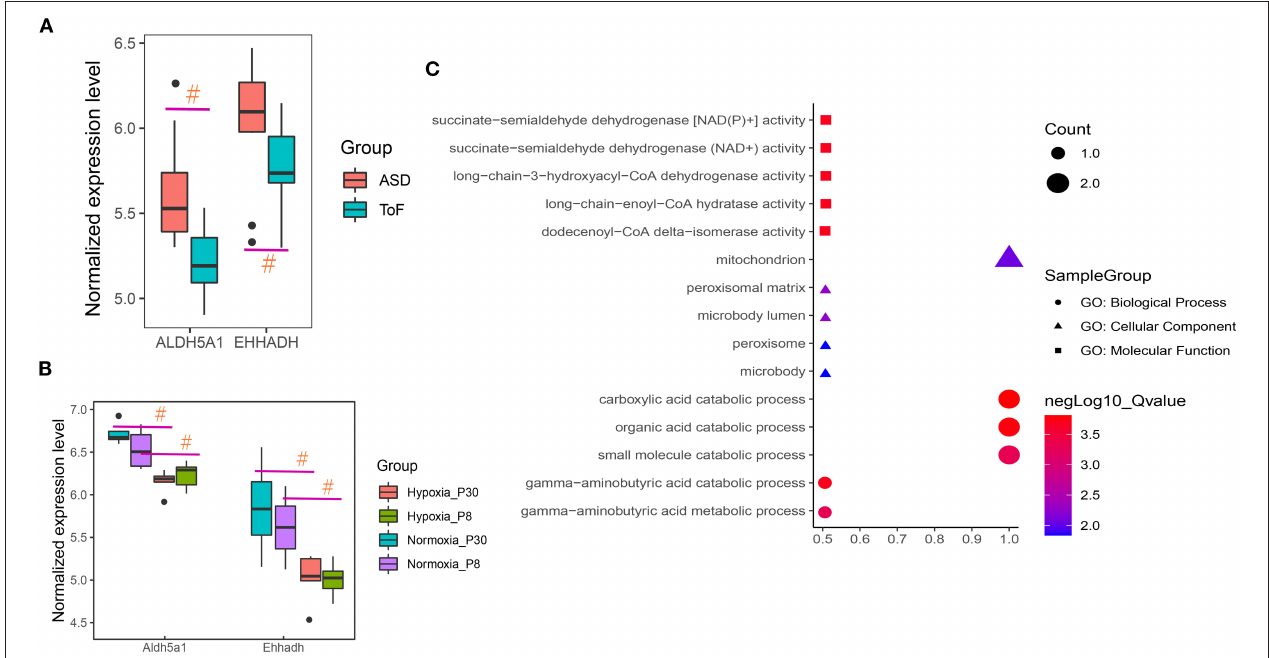
FIGURE 6 | Hub regulator expression and functional enrichment analysis of ToF and ASD RA specimens. (A,B) Hub genes showed differences in ToF and ASD RA specimens in the GSE132176 and GSE169214 datasets, respectively. (C) Hub terms were enriched in response to hub regulators. # p < 0.05.